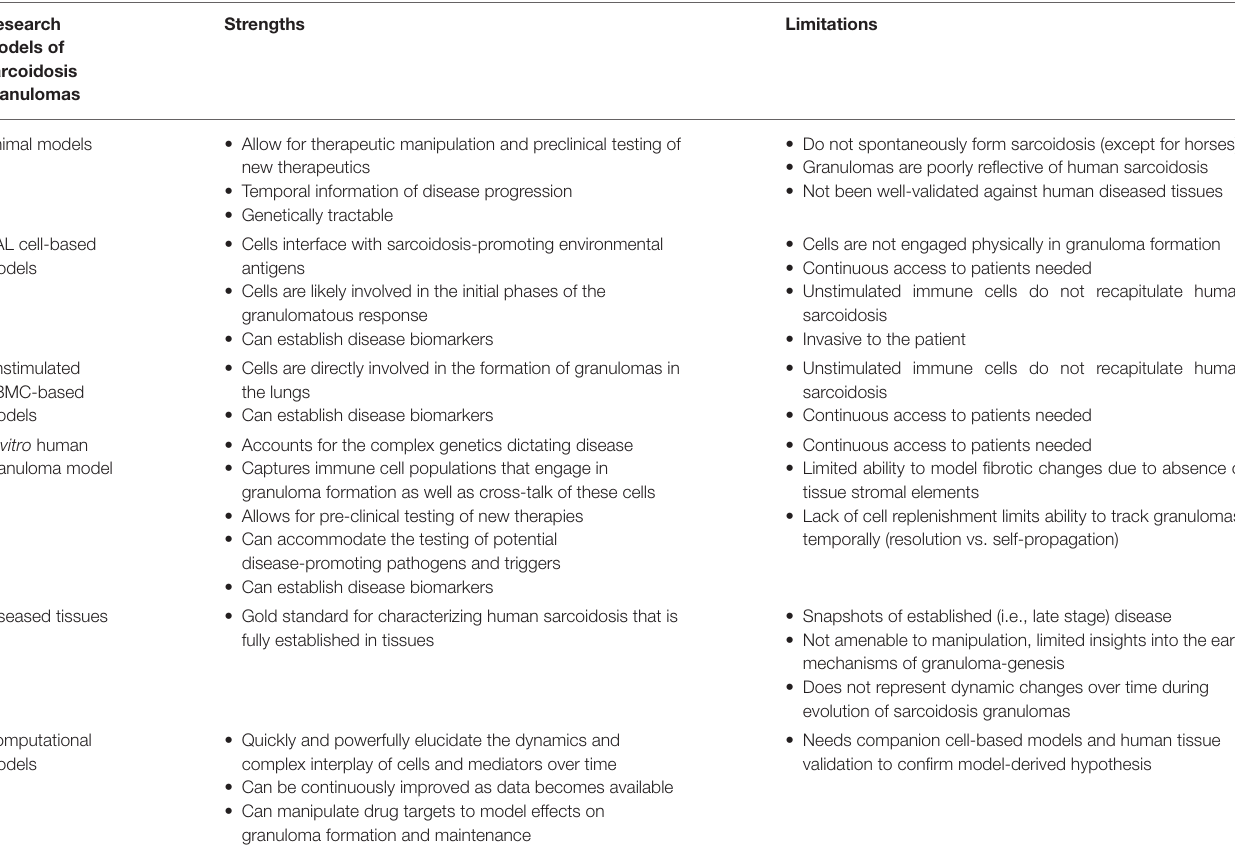
TABLE 1 | The strengths and limitations of current sarcoidosis research models. Research models